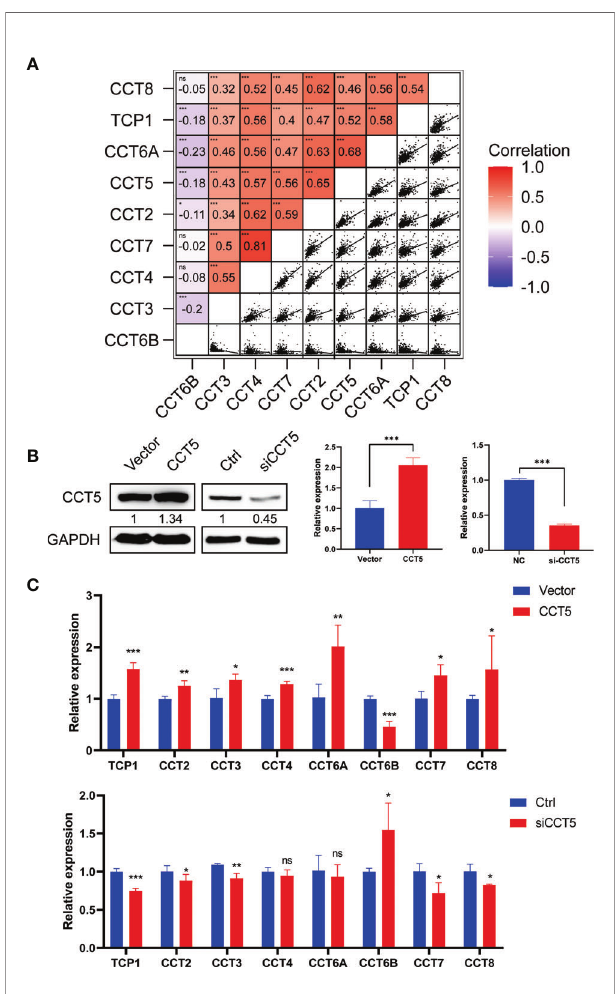
FIGURE 7 | Signi fi cant correlation between expression levels of TRiC subunits in HCC. (A) Pearson correlation analysis of the TRiC subunits in HCC (from cBioPortal). (B) Ef fi ciencies of CCT overexpression and knockdown in SK-HEP1 cells following plasmid and siRNA transfection, respectively, as con fi rmed by western blotting (left) and qPCR (right). (C) CCT5 overexpression and knockdown-induced changes in the expression of other subunits were con fi rmed by qPCR. *p < 0.05, **p < 0.01, ***p < 0.001. ns, no signi fi